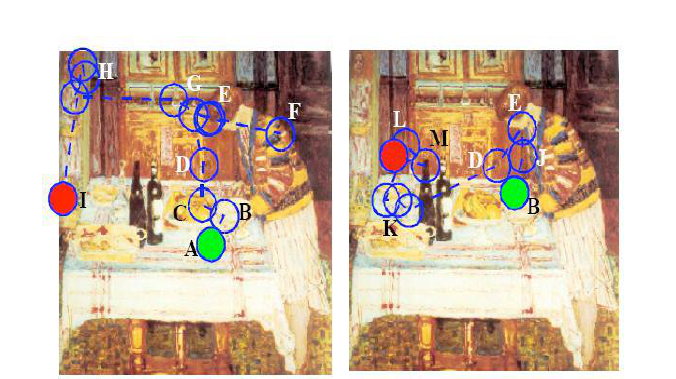
Figure 3a: Examples of two scanpaths and their